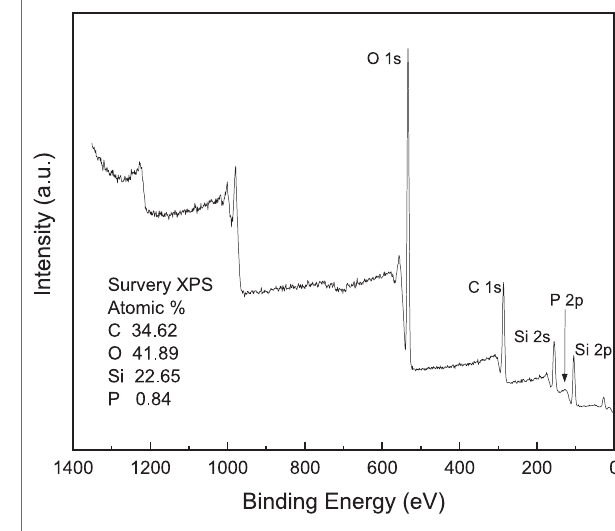
FIGURE 5 | XPS spectra of SA-g-DOPO.